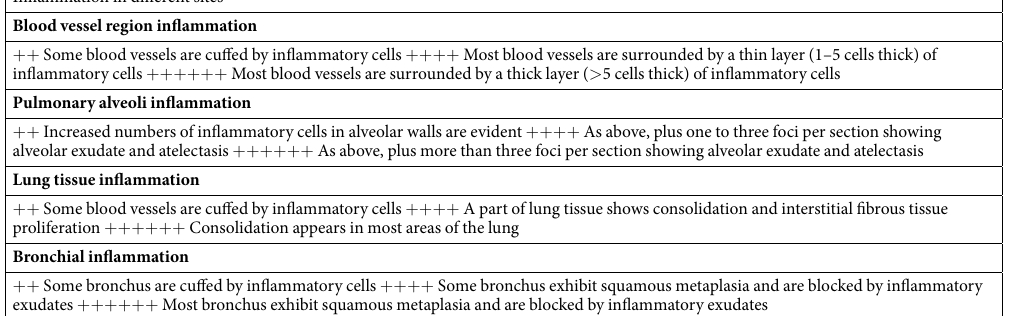
Table 1. Histology Scoring Criteria. The three levels of inflammatory response for each index, which was designated as ++ , ++++ and ++++++ , according to the criteria listed in the above table. The milder inflammation was designated with reduced number of “ + ” as indicated in respective Figures. To warrant the objectivity of the histology scoring, two pathologists from different labs read each slide in a double-blinded way and an average value was taken as the final